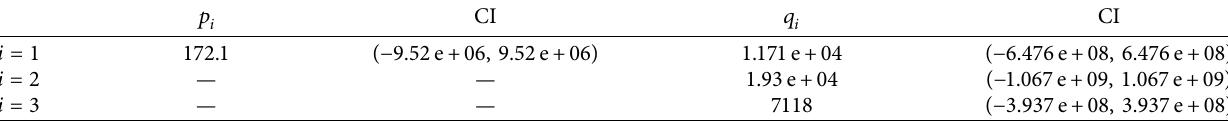
Table 15: HoF vs. Re G